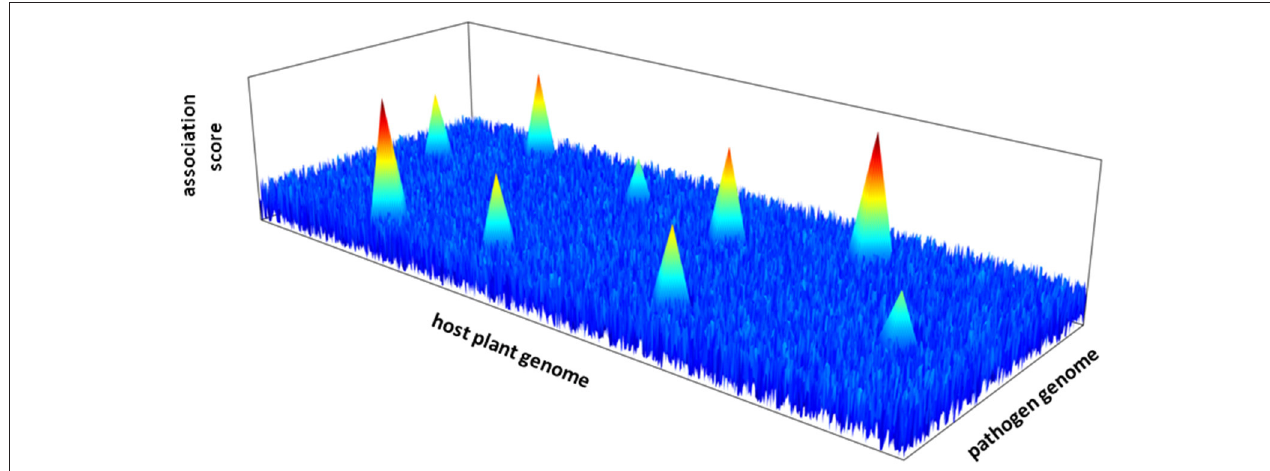
FIGURE 2 | Illustration of the four steps of the free-phenotyping joint GWA mapping approach. Step 1: paired sampling of plants and microbiota in wild populations. Each color corresponds to a different plant population. Step 2: isolation of putative pathogenic strains. The green circle corresponds to the putative pathogenic strain whereas gray circles correspond to other members of the microbiota. Steps 3 and 4: whole-genome sequencing of both plants and microbial strains and genome-to-genome statistical analysis.